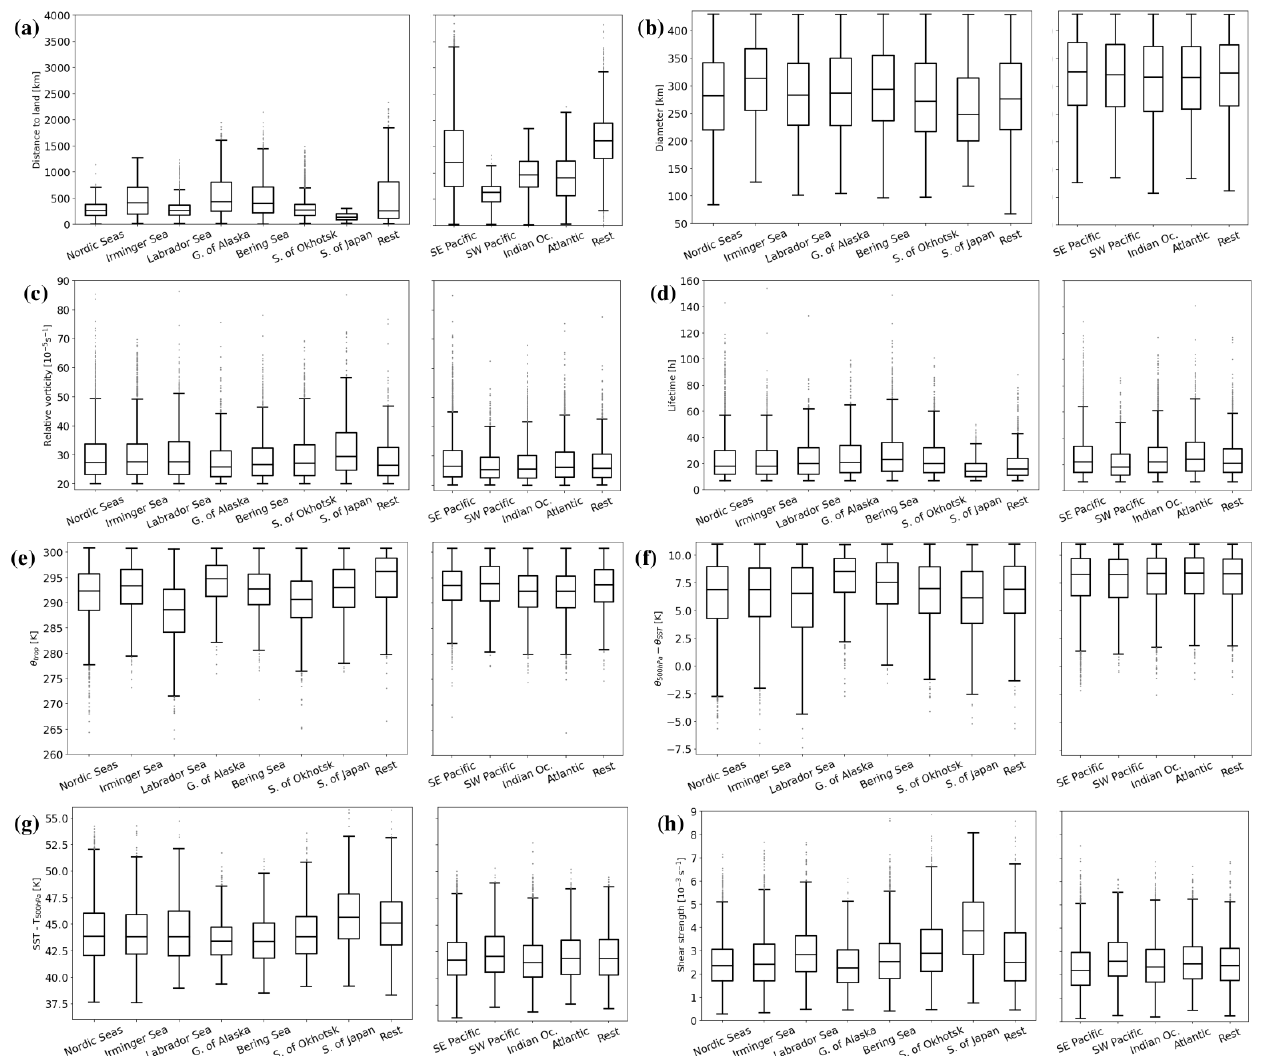
Figure 7. Parameter distributions of polar lows for the different regions. The lifetime maximum of the polar-low tracks is used for the computation of (a) the distance to land, (b) the vortex diameter, (c) the relative vorticity, (g) SST − T 500hPa , and (h) the shear strength. For (e) θ trop , the lifetime mean is calculated, and for (f) θ 500hPa − θ SST , the lifetime minimum is calculated. (d) The lifetime is the duration of the polar